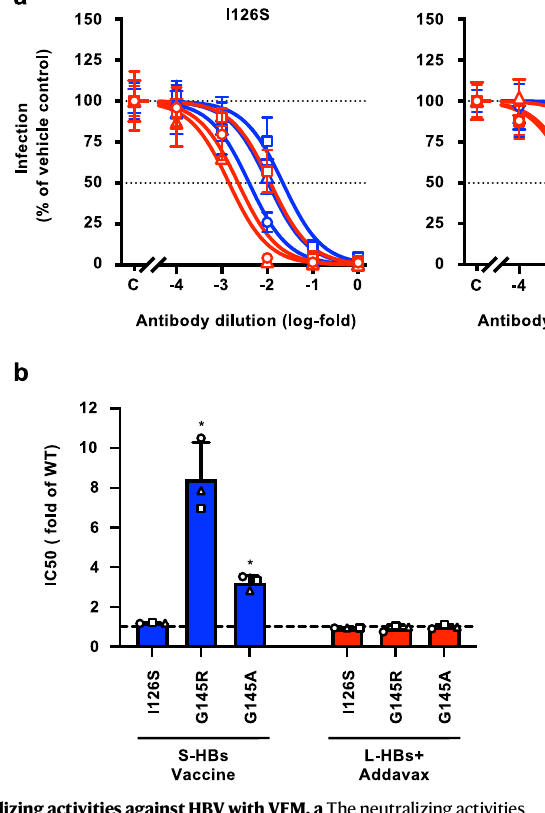
NL activities in infected cells at 7 days after infection. b The IC 50 values were calculated by drawing the dose – response curves with the log (inhibitor) vs. nor- malized response model and comparing the percentages to that of HBV/NL-WT. Themean±SDofthreeanimalsisindicated.* P =0.0033bytwo-tailedpaired t -test. Source data are provided as a Source Data fi